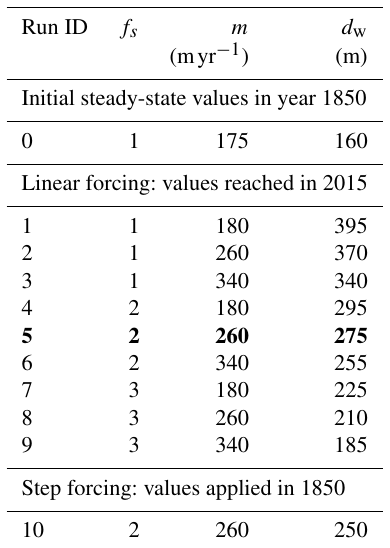
Table 2. Nine combinations of the perturbation parameters used in this study. Values shown here are those reached in 2015 after a linear perturbation from their LIA value shown in Table 1. Values for the SMB are perturbed to the same 2015 values for all model runs: G l = 0 . 0019yr − 1 , G u = − 0 . 00013yr − 1 , a 0 = 0 . 64mw . e . yr − 1 . Run 5 (in bold) is presented in more detail in the